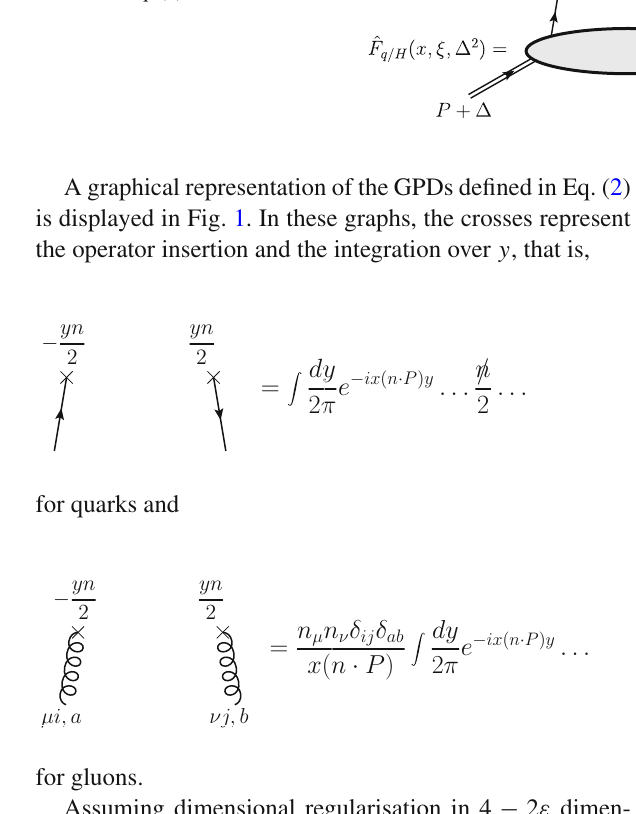
Fig. 1 Graphical representation of the parton-in-hadron GPDs defined in Eq. (2)